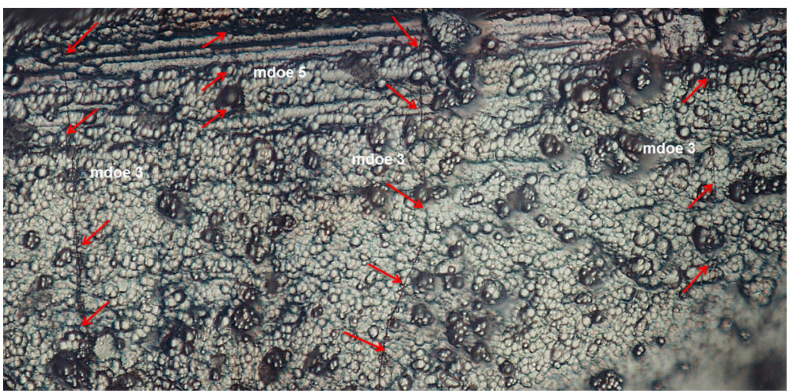
Figure 2. The matrix cracking mode 3 and mode 5 of cross-ply C/SiC composite under cyclic loading/unloading